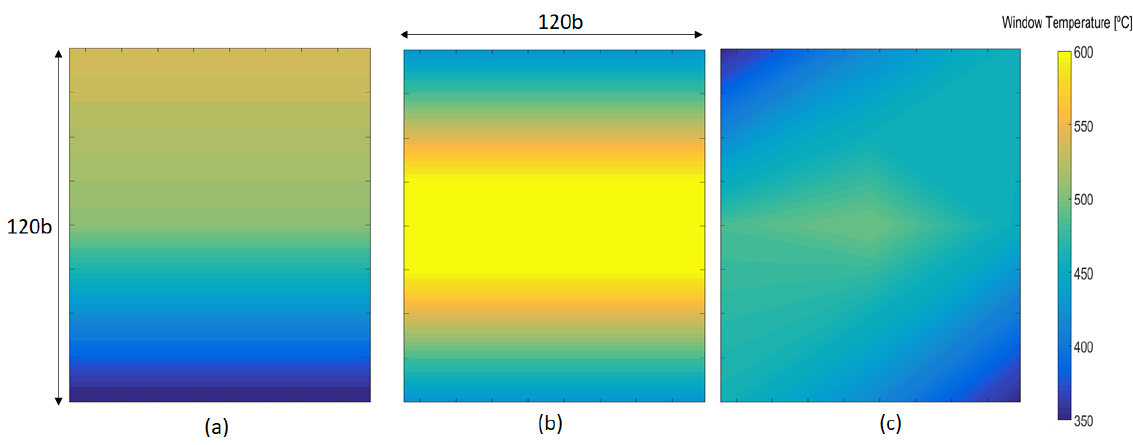
Figure 13. Local window temperature for different cooling schemes: ( a ) Scheme A; ( b ) Scheme B; and ( c ) Scheme